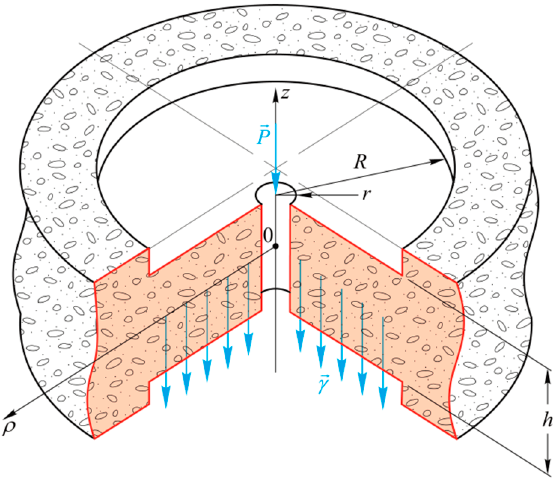
Figure 2. Calculation scheme of the rock mass.